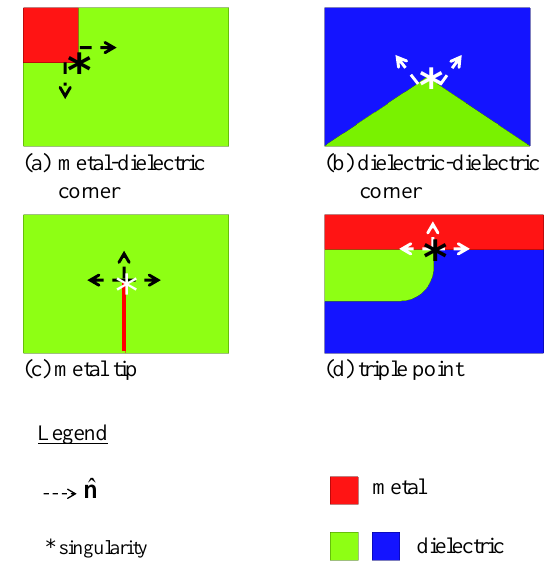
Figure 1: Typical field singularities, indicated by the as- terisks (*): (a) 90 ◦ metal-dielectric corner, (b) dielectric- dielectric corner, (c) metal tip, (d) triple point, where three different materials meet at one single point. The unit vec- tor normal to the interface ( ˆ n ) is displayed by the dotted arrows. Ambiguous definition of ˆ n occurs at the singular- ity points, where there is more than one arrow pointing to different directions depending on which edge of the corner is taken as reference. For the clarity of illustration, in (a) and (b) the arrows are not drawn exactly at the singularity points, but in their close